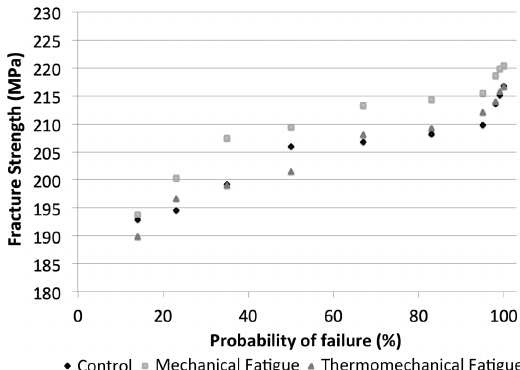
Figure 7. The fracture strength of titanium implants evaluated by Weibull